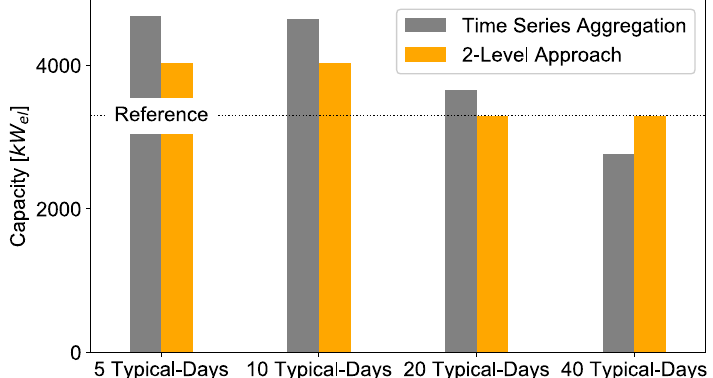
Figure 14. Deviation of installed photovoltaic capacities with the 2-Level Approach and time series aggregation compared to full time series.